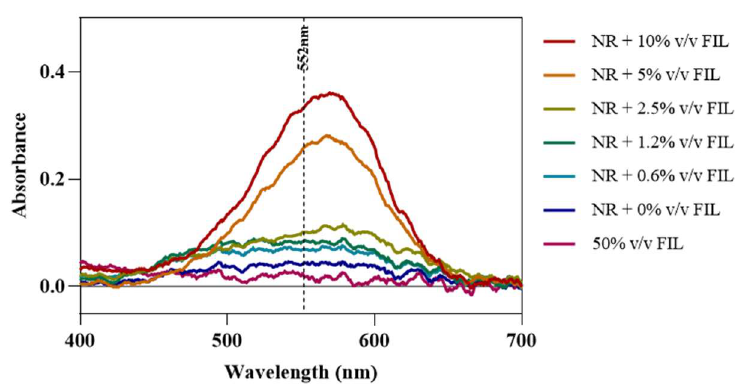
Figure 11. Nile Red absorbance spectra in the presence of increasing concentrations of